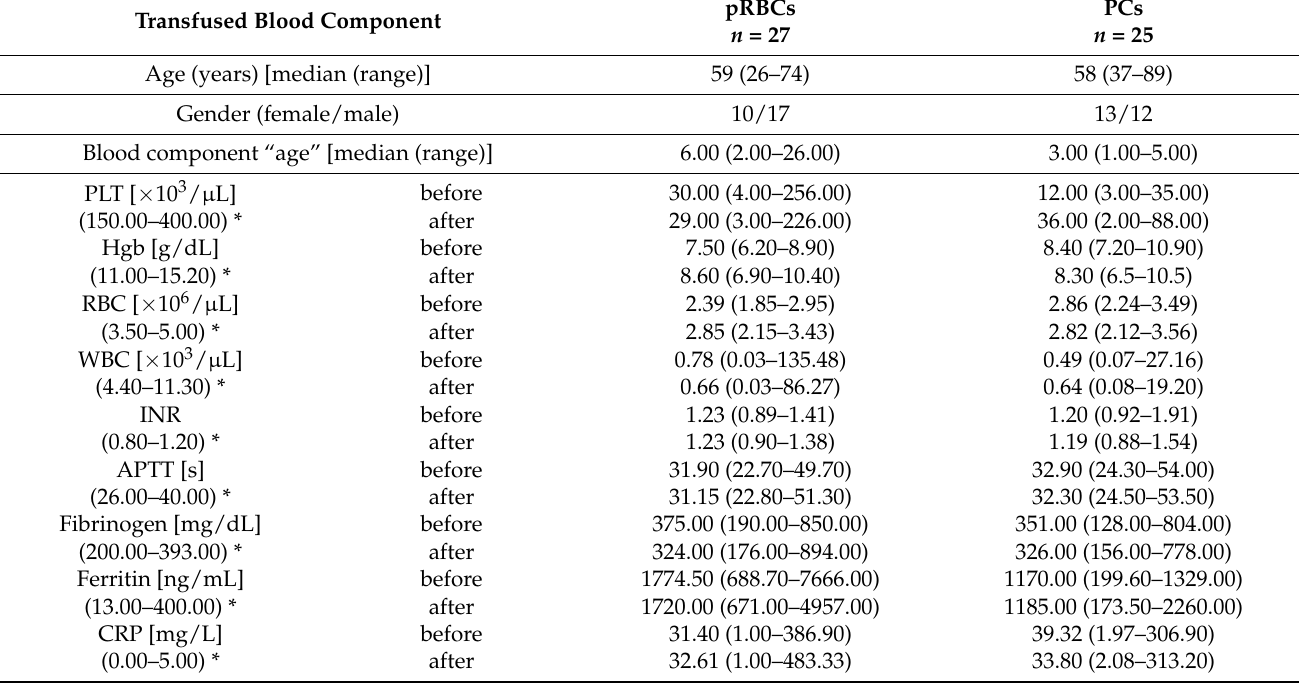
Table 1. Characteristics of acute myeloid leukemia (AML) patients before and 24 h after transfusion of red blood cells or